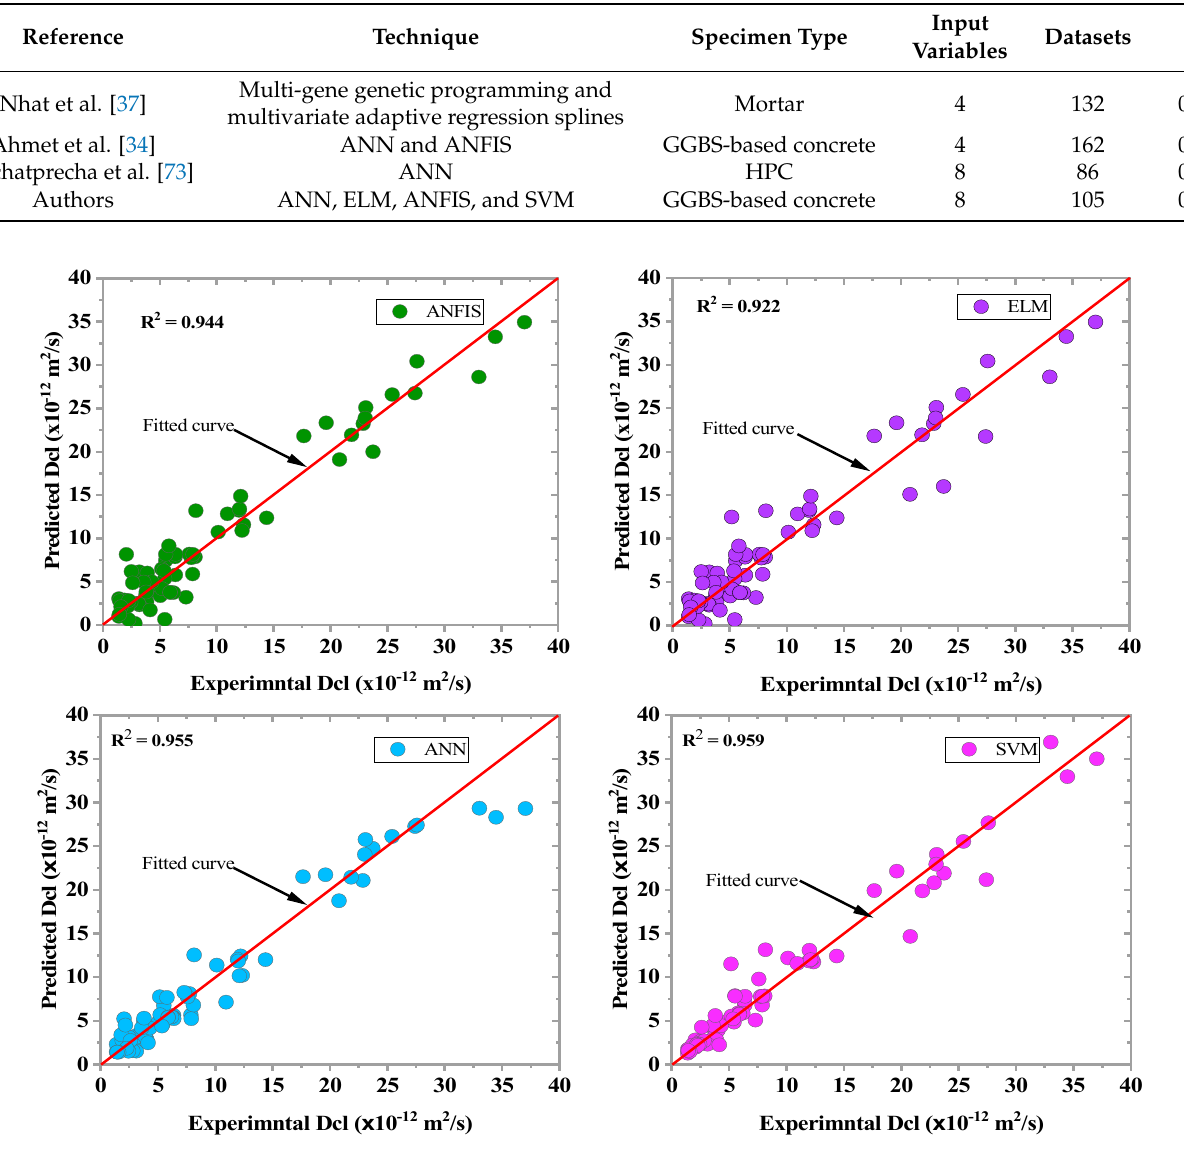
Figure 8. Observed vs. predicted plots of the ML models for the training phase.